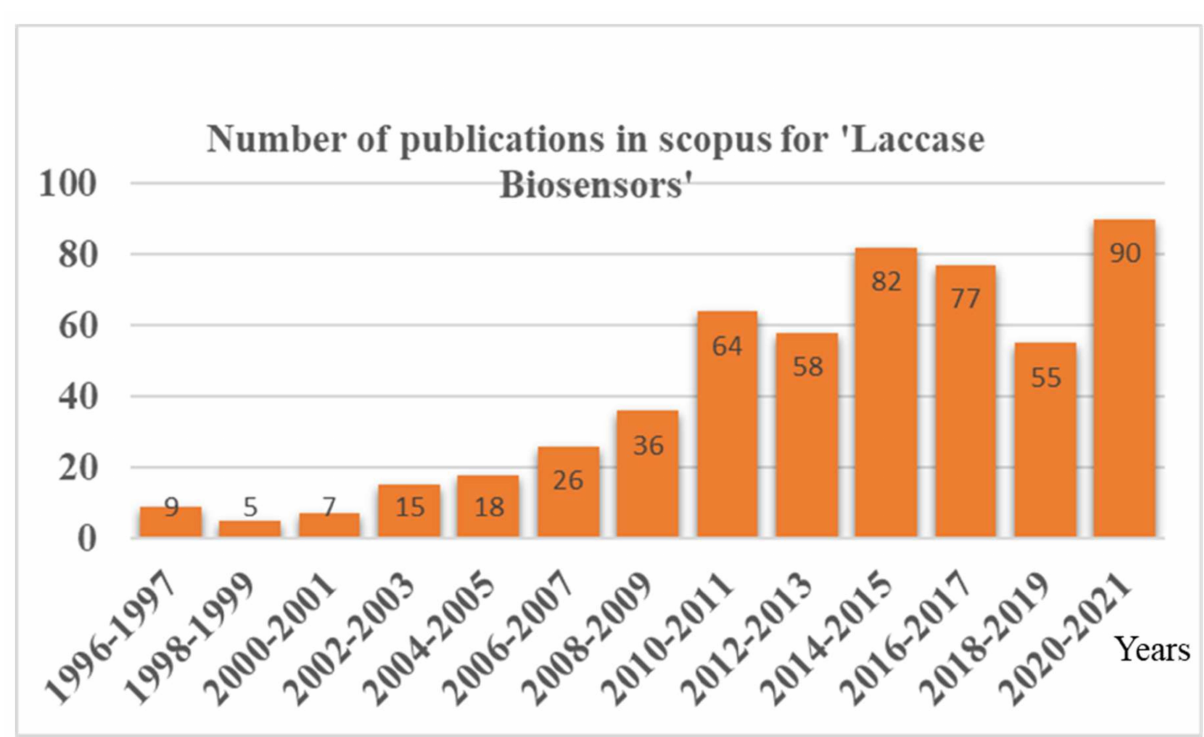
Figure 1. Year-wise publications in Scopus reported for the document search for ‘Laccase